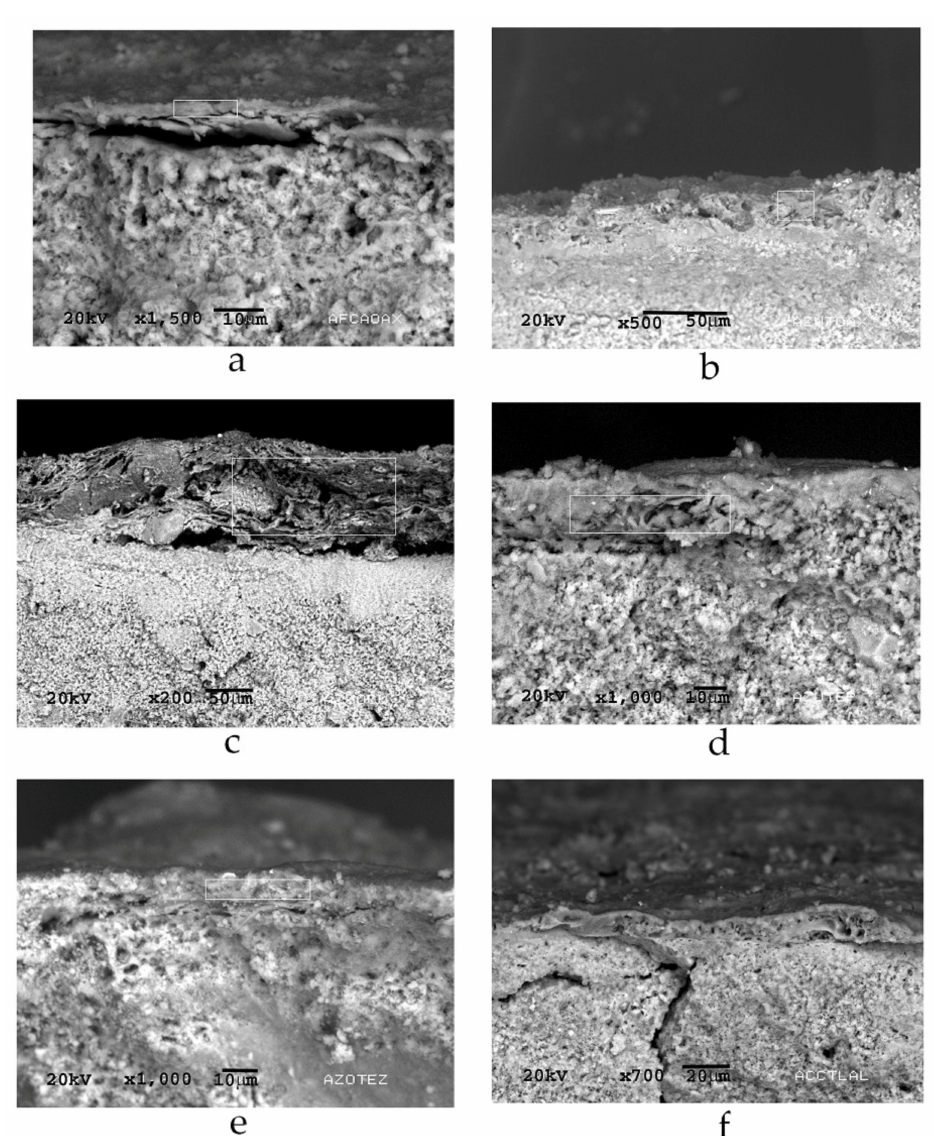
Figure 4. SEM images of different blue samples. ( a ) Oaxtepec upper cloister, cross-section with three main layers. The one at the top is the paint layer that is placed over a stucco barely distinguishable from the plaster by its coarser and more porous texture. ( b ) Oaxtepec lower cloister, cross-section. The dark layer on top is the blue paint placed over a stucco, and on the bottom, a less porous plaster is observed. ( c ) Ocuituco, cross-section. The blue paint layer is thick and placed over a compact stucco layer; at the bottom, a more porous plaster is observed. ( d ) Tepeapulco, cross-section. A thin dark layer of blue paint is placed over a stucco; then, the more compact plaster is seen. ( e ) Tezontepec, cross-section. A thin dark layer of blue paint is placed over a thin stucco that is clearly separated from the plaster on the bottom. ( f ) Tlaltizapan, cross-section. The paint layer is directly placed over the